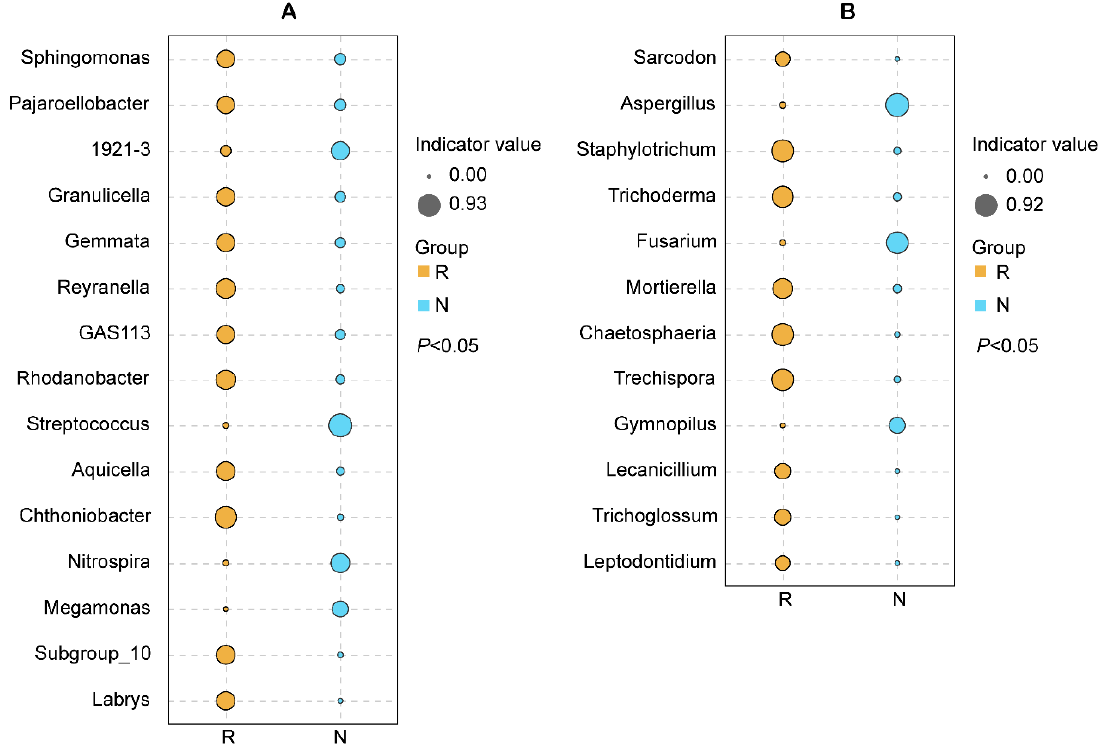
Figure 4. Bacterial ( A ) and fungal ( B ) biomarkers of the rhizosphere (R) and non-rhizosphere (N) samples at the genus level based on indicator analysis. The size of the cycle indicates the indicator value of each genus. n = 3.